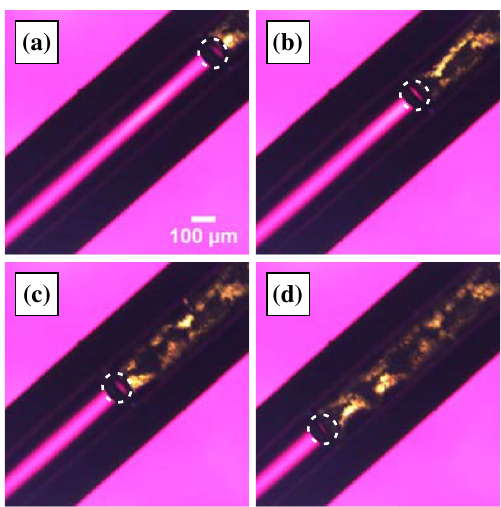
Figure 5. Crystal growth for OTP in a capillary tube with inner diameter 0.13 mm at T = 283 K . ( a ) t = 95.7 s , ( b ) 98.7 s, ( c ) 101.7 s, and ( d ) 104.7 s. The dotted lines show the positions of the bubble. Although the crystal is not in contact with the liquid, it was observed that the crystal keeps growing. It is also remarkable that the growth rate is 100.6 µ m/s , which is close to the filamentous crystal growth rate (see also Fig.